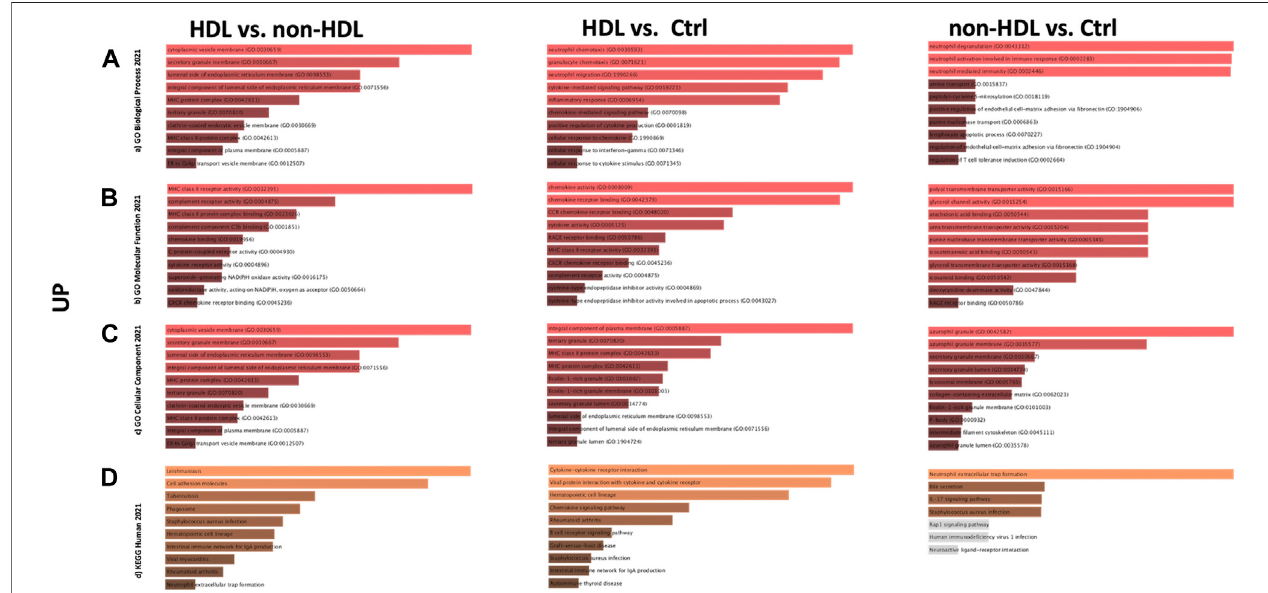
FIGURE 1 | Gene Ontology (GO) and putative pathways of common upregulated DEGs in BPS/IC obtained for HLD vs. non-HLD, HLD vs. Ctrl, and non-HLD vs. Ctrl subgroup analysis. TheGO terms were extracted from the Enrichr platform inthe form of bar graphs for each subgroup analysis, inwhich thecolor and length ofthe bars decrease as the signi fi cance decreases. Signi fi cant ( p -value < 0.05) GO terms were analyzed for (A) biological processes, (B) molecular functions, and (C) cellular components aspects, and (D) top 10 signi fi cant putative pathways predicted with the Enrichr platform obtained from the Kyoto Encyclopedia of Genes and Genomes (KEGG).